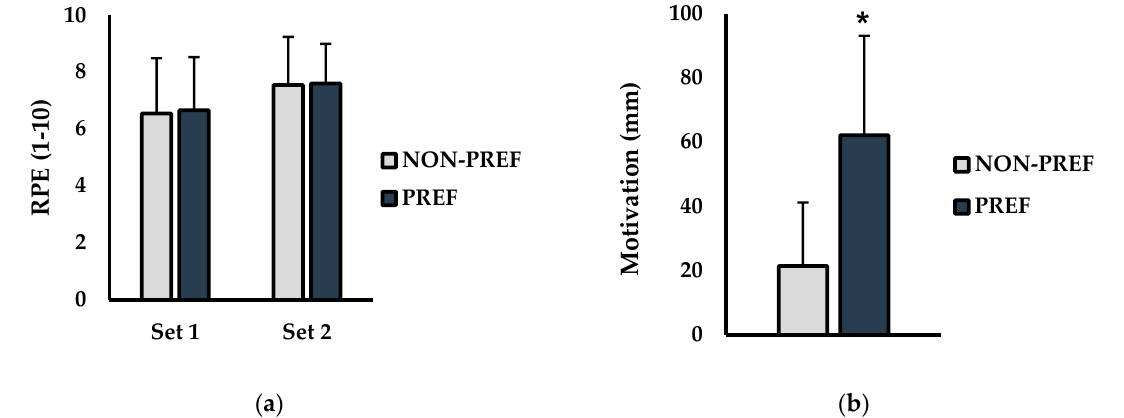
Figure 2. RPE and exercise motivation between non-preferred (NON-PREF) and preferred (PREF) warm-up music conditions ( a ) Set-to-set changes in rate of perceived exertion (RPE; 1–10 scale) ( b ) Motivation (mm) following the warm-up for each condition. * indicates significantly different than NON-PREF ( p ≤ 0.05).